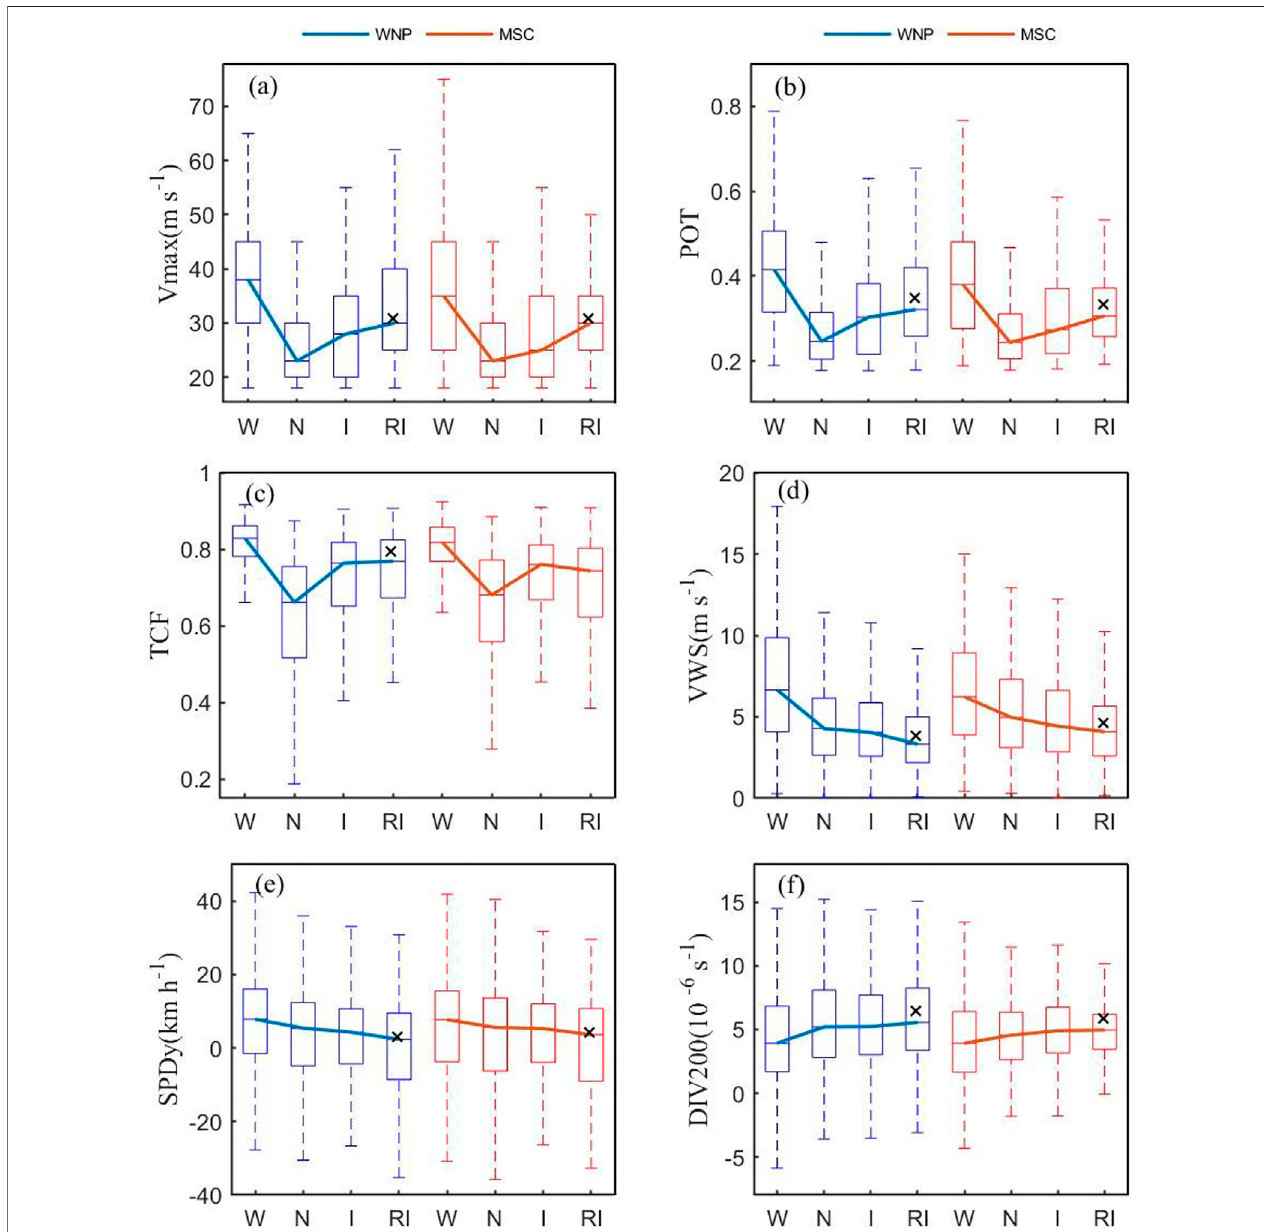
FIGURE 6 | Box plots and median lines of (A) Vmax (m s − 1 ), (B) POT, (C) TCF, (D) VWS (m s − 1 ), (E) SPDy (m s − 1 ), and (F) 200 hPa divergence (DIV200, 10 – 6 s − 1 ) fordifferentTCintensi fi cationratesovertheWNP (A,C,E) andtheMSC (B,D,F) .ThebluerepresentsWNP,andtheredrepresentsMSC. “ × ” showsdifferencesbetween RI and non-RI being statistically signi fi cant above 95% con fi dence level based on the two-sided Student ’ s t test. SPDy, slow moving component perpendicular to the coastline.